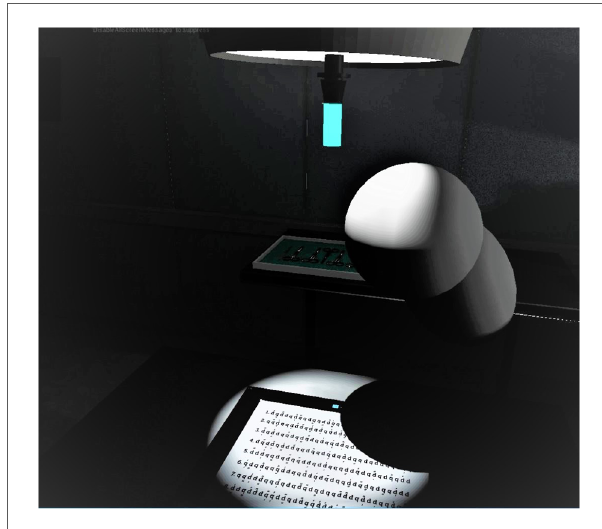
FIGURE 2 The digital version of the D2-test is shown on the simulated operating table, partially concealed by an occluder roughly resembling the shape of a human. In this situation, the light source simulated to be above the table needs to be re-adjusted